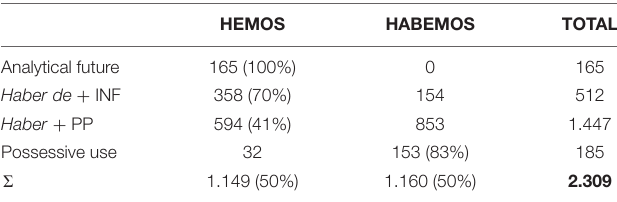
TABLE 2 | Frequencies of use (total instances and as a percentage) of hemos and habemos in different syntactic contexts.